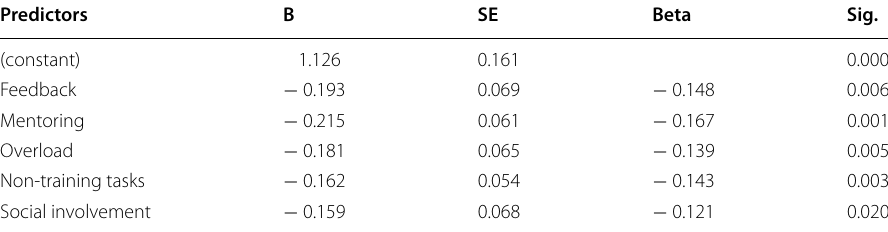
0.261, adjusted R 2 0.252 = =